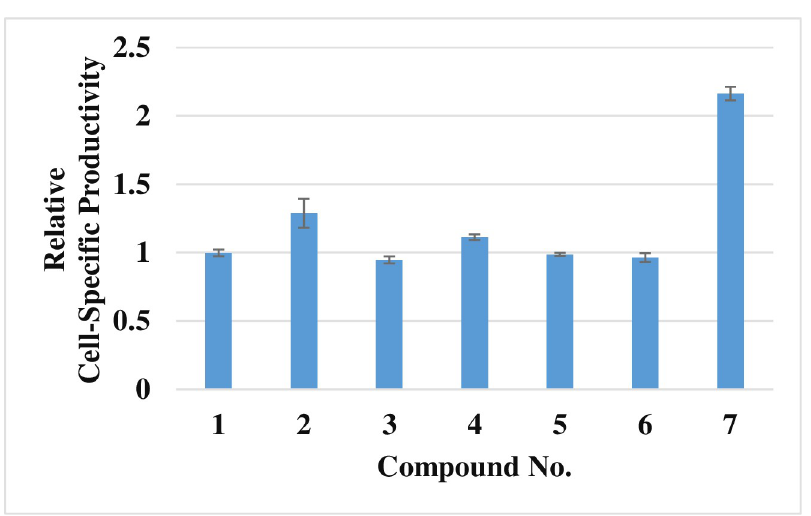
Fig 13. Evaluation of the effect of the five chemical components derived from MPPB on cell-specific productivity. Each chemical compound was added on day 0 and evaluated on day 3. The tested concentration of each chemical compound was 0.32 mM. Lane 1: dimethyl sulfoxide (control); lane 2: MPPB; lane 3: N -(2,5-dioxopyrrolidin-1-yl) benzamide; lane 4: 4-(2,5-dimethyl-1 H -pyrrol-1-yl) benzamide; lane 5: succinimide; lane 6: 4-aminobenzamide; lane 7: